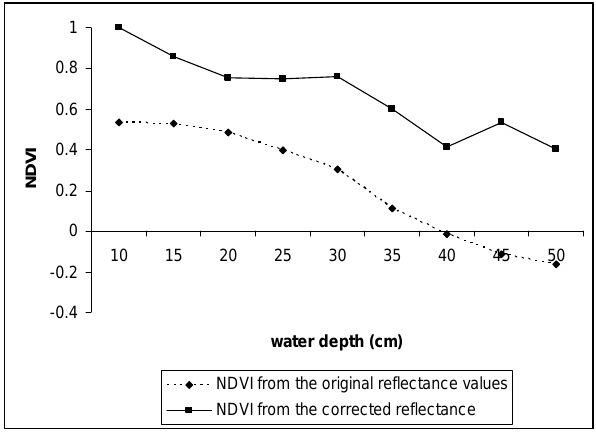
Figure 10: Water depth-induced changes in the Normalized Difference Vegetation Index (NDVI) values compared with the NDVI values calculated from the corrected reflectance (SAV reflectance – black panel reflectance) at the corresponding